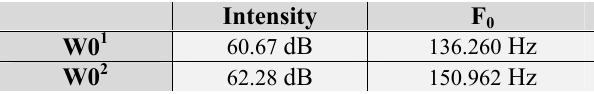
Table 1. Global intensity and F 0